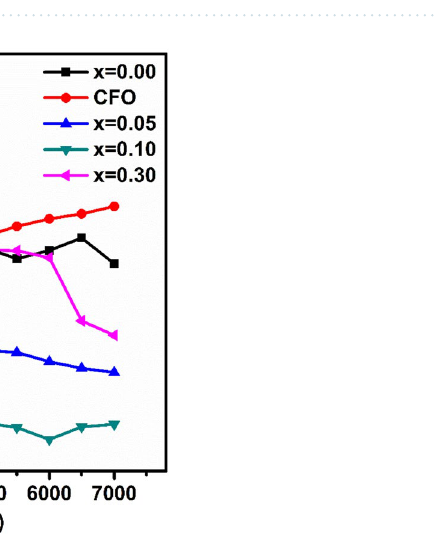
Figure 10. (a) Arrott–Belov–Kouvel (ABK) plots of (1 − x)BFO–xCFO (CFO, x = 0.00, 0.05, 0.10 and 0.30) samples at room temperature, (b) remnant magnetization and saturation magnetization versus CFO concentration.